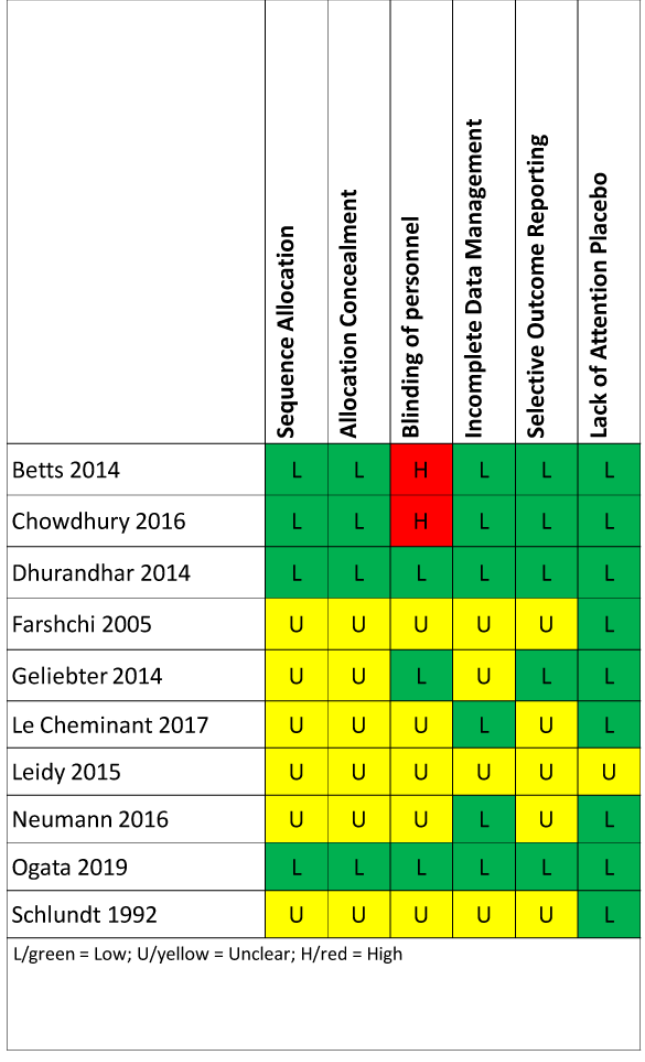
Figure 4. Risk of bias assessment. Each included paper was assessed for risk of bias using the Cochrane Risk of Bias tool. Given that the interventions are obvious to participants (eating versus skipping breakfast), we only coded blinding of personnel, and readers should be aware of the risk of non-blinded